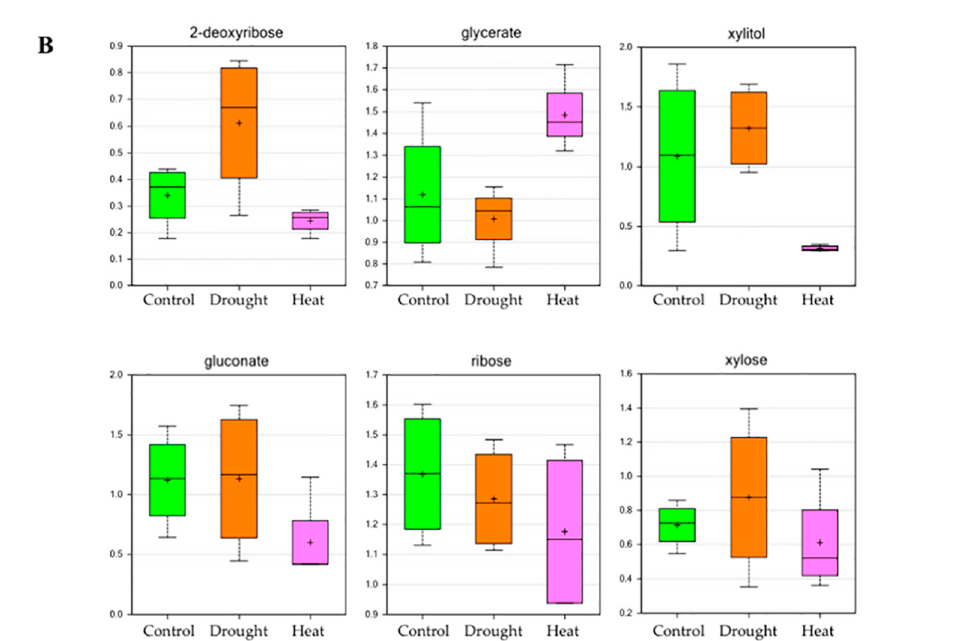
Figure 3. Effect of drought and heat stresses on metabolites related to the pentose phosphate pathway. ( A ) The pink colored metabolites indicate downregulation in response to heat stress, orange colored metabolites indicate downregulation in response to drought stress. ( B ) Box plots showing relative abundances of PPP metabolites and sugar compounds under control, drought, and heat stress conditions (pink highlights indicate heat stress-affected; box plot description is the same as Figure 2).